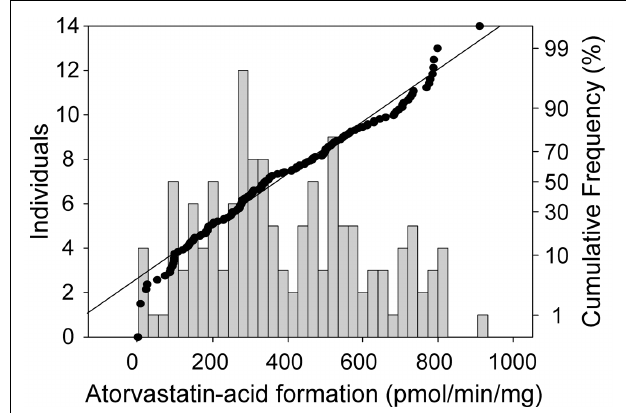
FIGURE 1 | Frequency histogram (left axis) and cumulative frequency (right axis) showing population distribution of the hydrolysis of atorvastatin-lactone (10 μ M) to atorvastatin-acid in human liver microsomes ( N = 142). Incubations (5 μ g of microsomal protein) were performed in the presence of 1mM CaCl at 37˚C for 30min. Atorvastatin-acid was quantitated by LC–MS/MS analysis.